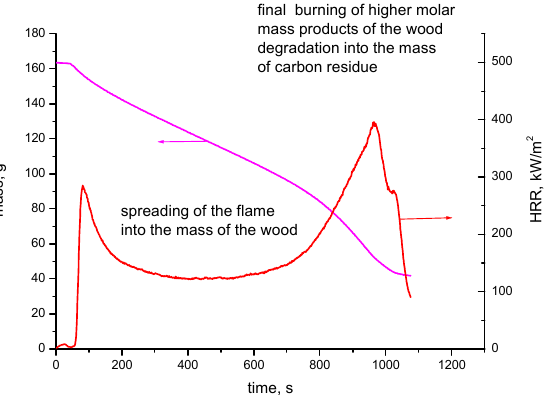
Figure 4. The average HRR–time and mass-loss runs (from 4 parallel experiments) at 35 kW/m 2 for Cumaru.